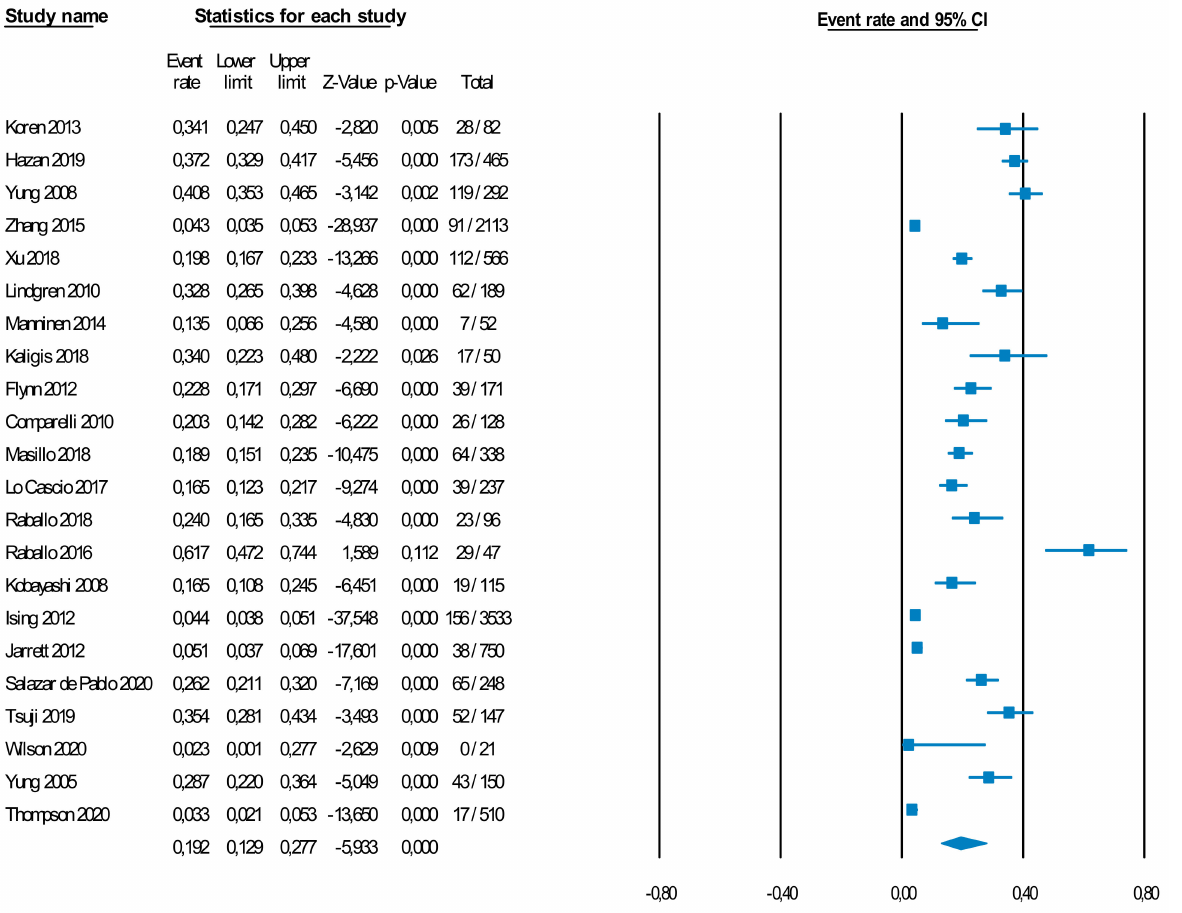
Figure 3. Random effect meta-analysis (forest plot) of the prevalence of CHR-P individuals in clinical samples. A total of 19.2% (95% CI = 12.9–27.7%) of individuals in the clinical samples were found to be at